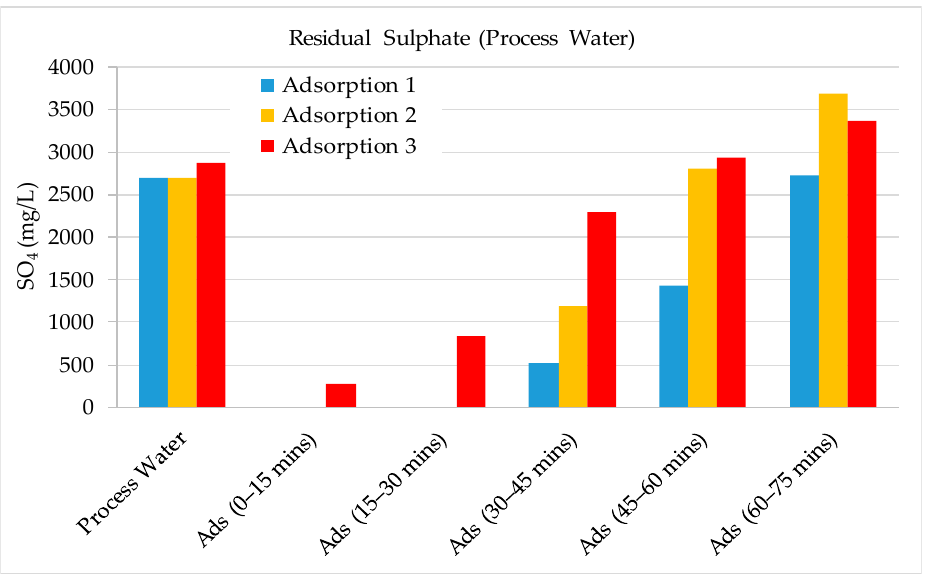
Figure 10. Concentration of residual sulphate from three adsorption experiments conducted on the Process Water.